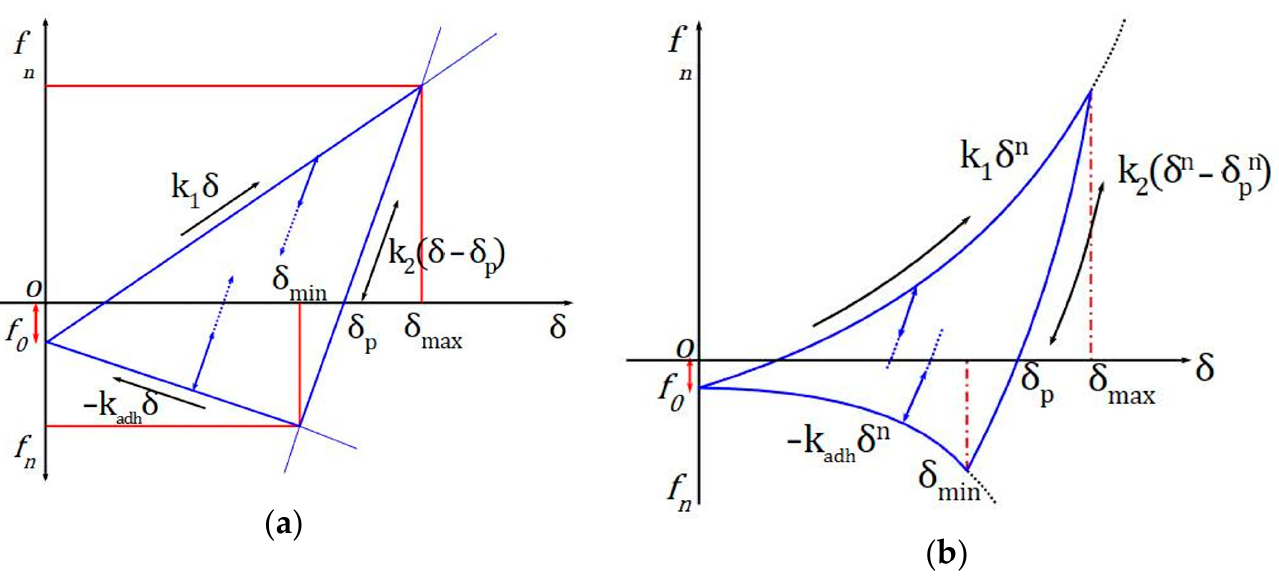
Figure 6. Edinburgh elasto-plastic adhesion model (EEPA) normal contact force-displacement rela- tionship ( a ) linear and ( b ) non-linear [50].